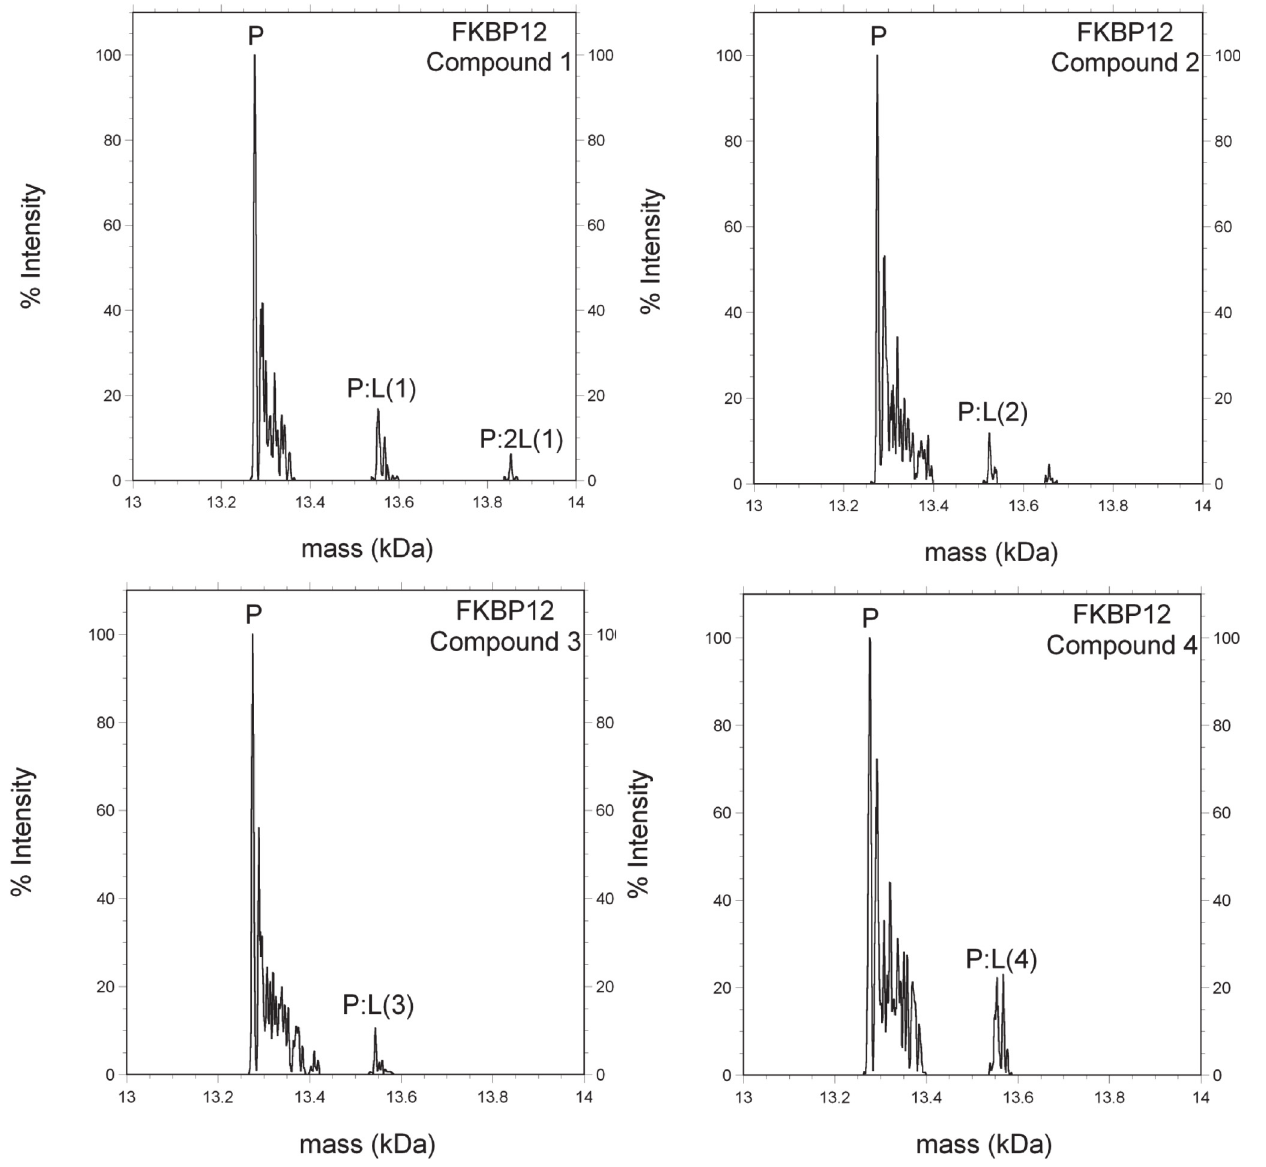
Fig 5. Small molecules bound to FKBP12 in ESI-MS.